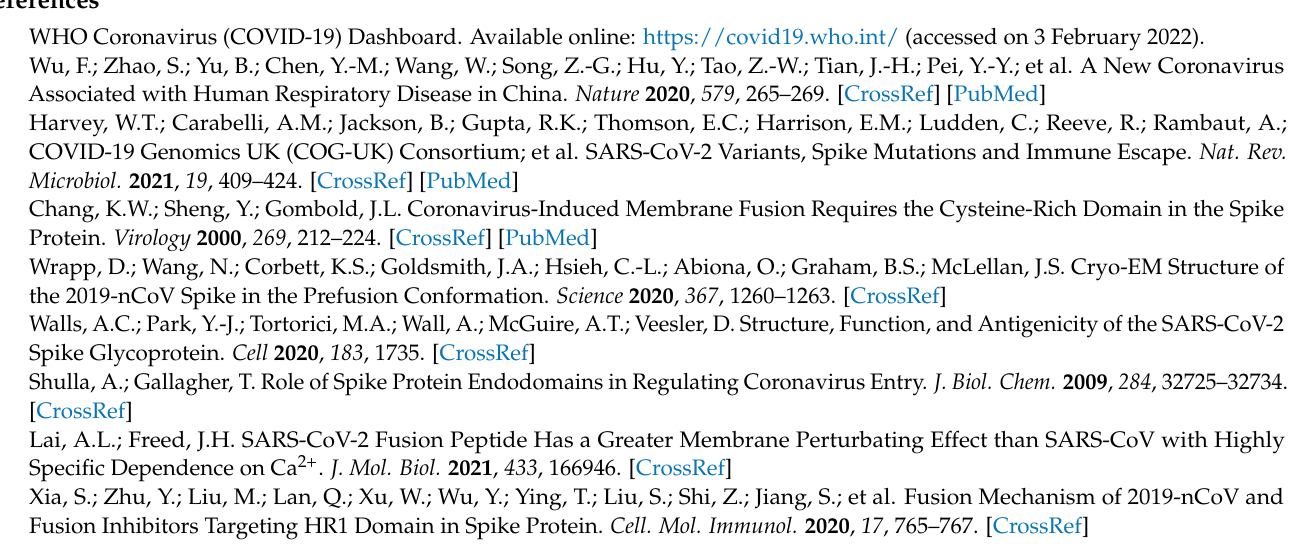
(ACE2) ectodomain; Figure S3: Multiple sequence alignment and construction of the phylogenetic tree of SARS-CoV-2 VOCs; Figure S4: Conservation profile of the Spike protein among VOCs; Figure S5: Mutations in the Spike protein of SARS-CoV-2 VOCs result in different mechanisms to evade the immune system, increase the infectiveness, and spread the virus faster in the population; Table S1: Conservation score in the Consurf Server